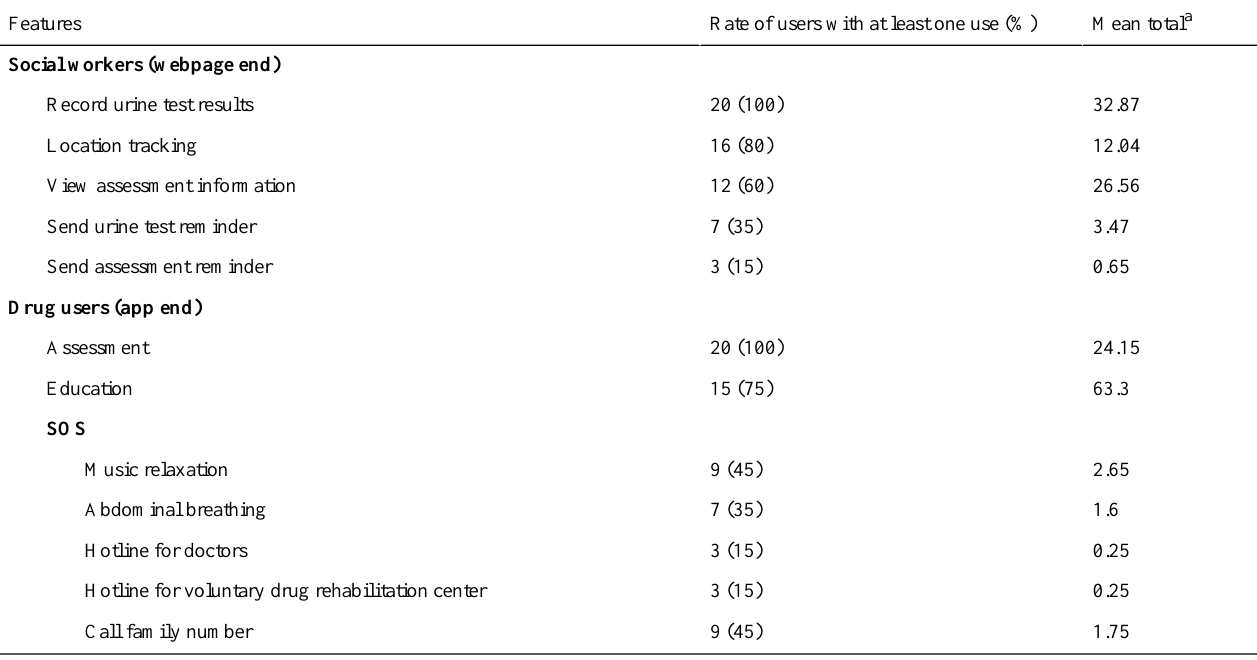
Mean total a Rate of users with at least one use (%)Features